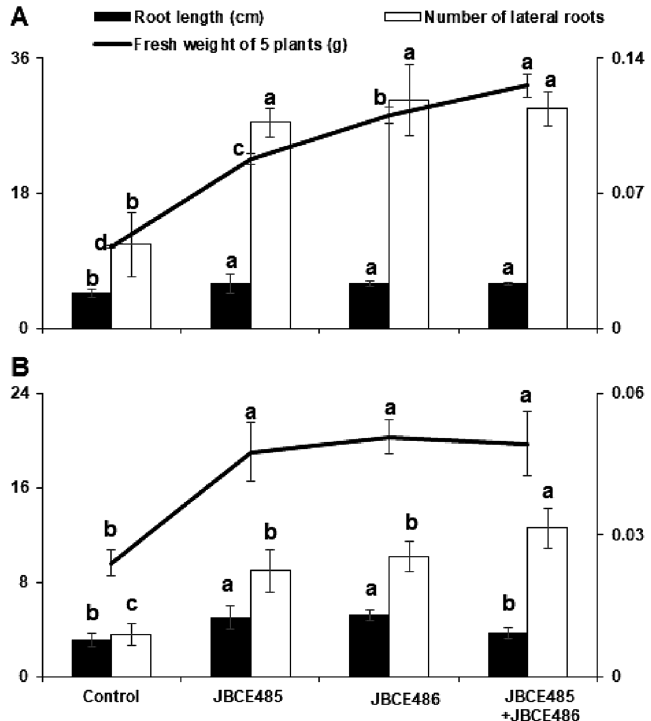
Figure 6. Growth promotion and salt stress alleviation of Arabidopsis by treatment with Pseudoxanthomonas sp. JBCE485 and Variovorax paradoxus JBCE486. Seeds of Arabidopsis thaliana Col-0 were treated with 1 × 10 7 CFU/mL cells of individual or combined strains of JBCE485 and JBCE486. Seeds were grown on ½ MS medium without ( A ) or with ( B ) 100 mM NaCl. The left Y-axis indicate root length (cm) and number of lateral roots, and right Y-axis indicate fresh weight of five plants (g). The data are represented as mean ± standard deviation and bars with the same letter do not differ significantly at P =